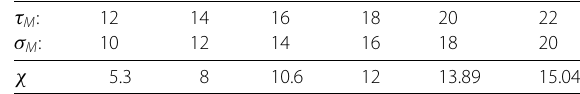
reduced significantly. A numerical example has been provided to illustrate the effective- ness of the results and their improvement over the existing